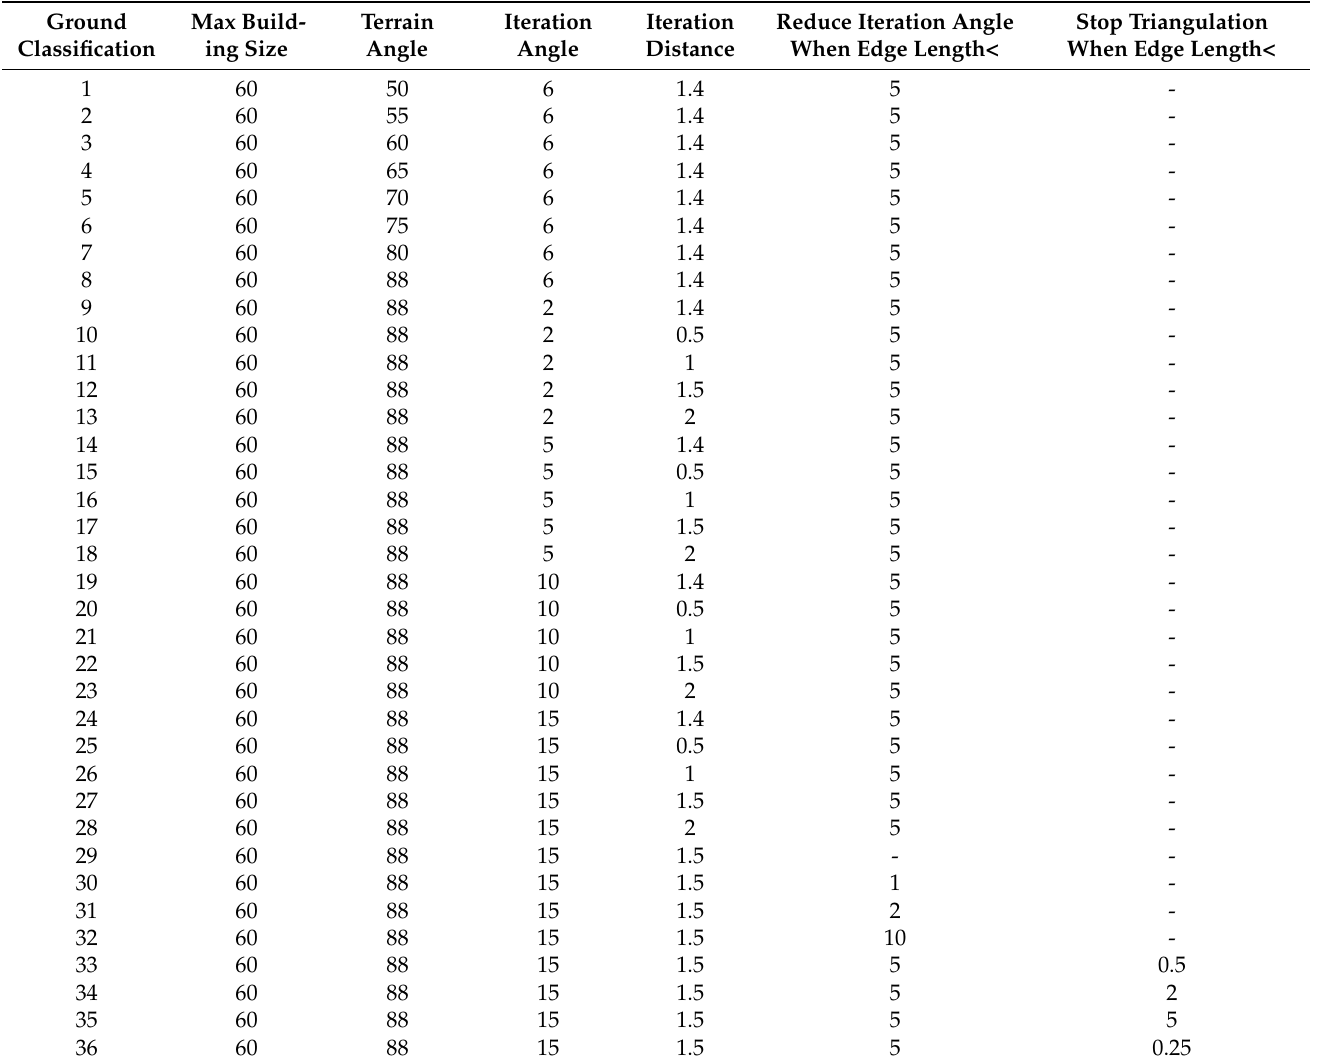
Table 1. TerraScan ground classification parameter modifications used in ground classification iteration